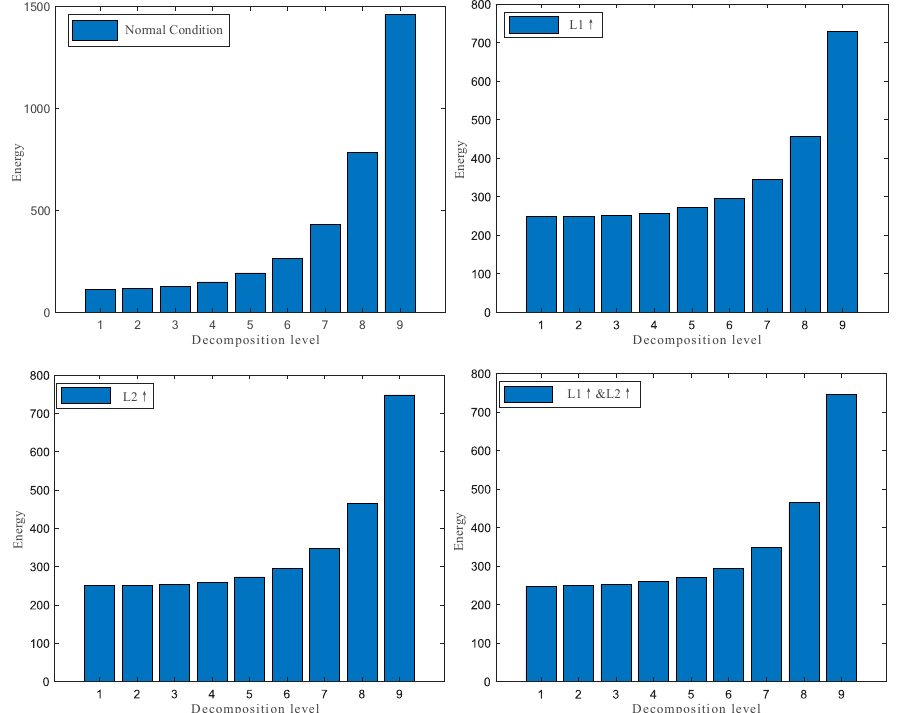
Figure 5. The result of wavelet packet decomposition (WPD) to the recessive weakness in the different level.